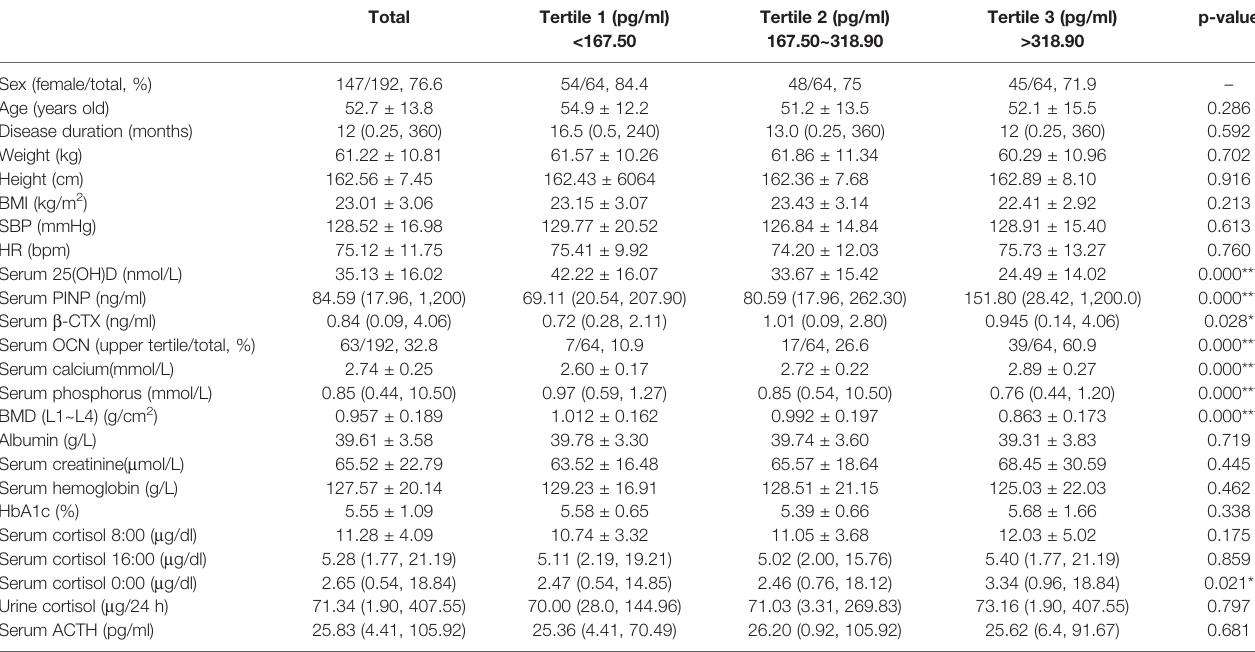
TABLE 2 | Baseline characteristics of PHPT patients in different PTH tertile